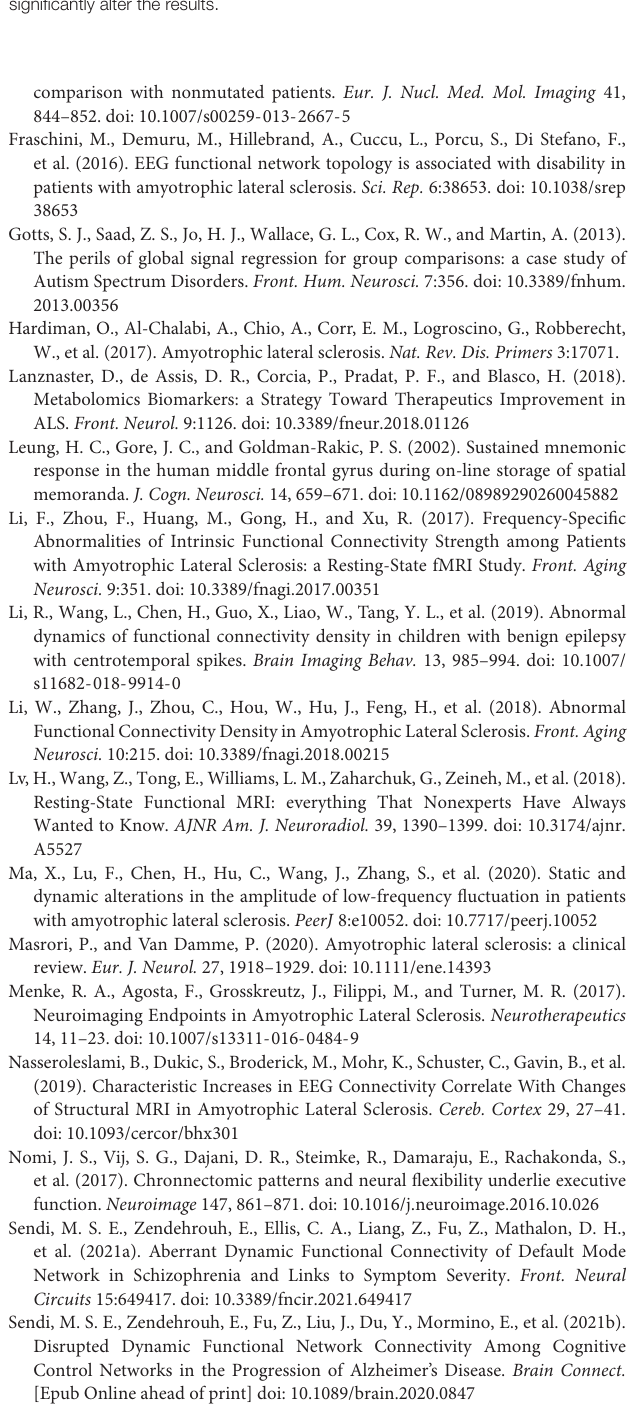
Supplementary Figure 1 | The influence of various sliding-window parameter settings on dFCD variability analysis. The dynamic functional connectivity analysis was conducted using the sliding-window approach using distinct parameter settings: (A) 60 TR window size and 3 TR sliding step; (B) 120 TR window size and 3 TR sliding step; (C) 90 TR window size and 2 TR sliding step; and (D) 90 TR window size and 4 TR sliding step. The main findings of the between-group comparison could be reproduced using different window lengths and sliding steps, suggesting that various sliding-window parameter settings do not significantly alter the